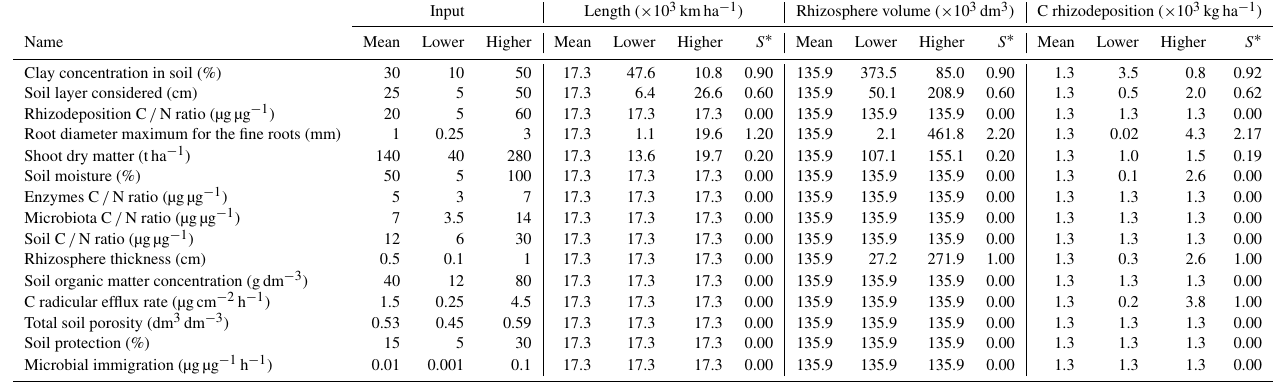
Table 1. Values of input variables used in the model in relation to estimates of fine-root length, rhizosphere volume, and C